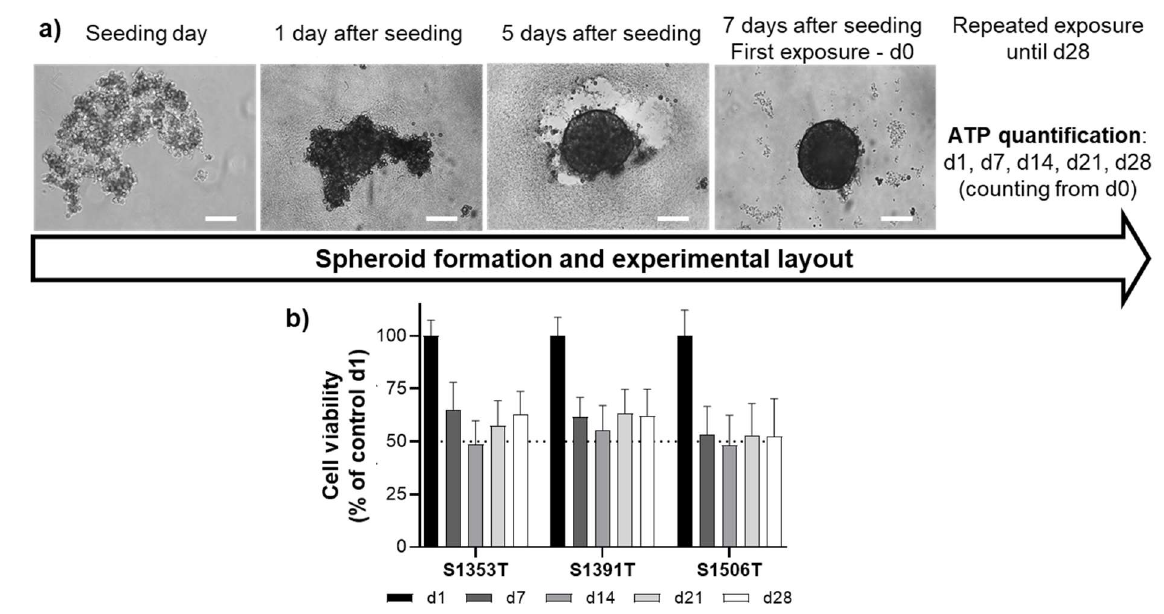
Figure 1. ( a ) Timeline of spheroid generation and experimental procedure. Cryopreserved PHH were seeded in ultra-low attachment plates at a density of 1500 cells per well. The plates were centrifuged (130 × g , 2 min) and kept in controlled atmosphere (37 °C, 5% CO 2 , humidified). The spheroids were formed 5 days after seeding and the first exposure was performed 7 days after seeding (d0). Scale bar = 100 μm. ( b ) Cell viability of control spheroids throughout the time-frame of the experiments. Results are expressed as mean ± standard deviation of at least 48 spheroids from each donor per time-point. ATP—adenosine triphosphate; d—day.